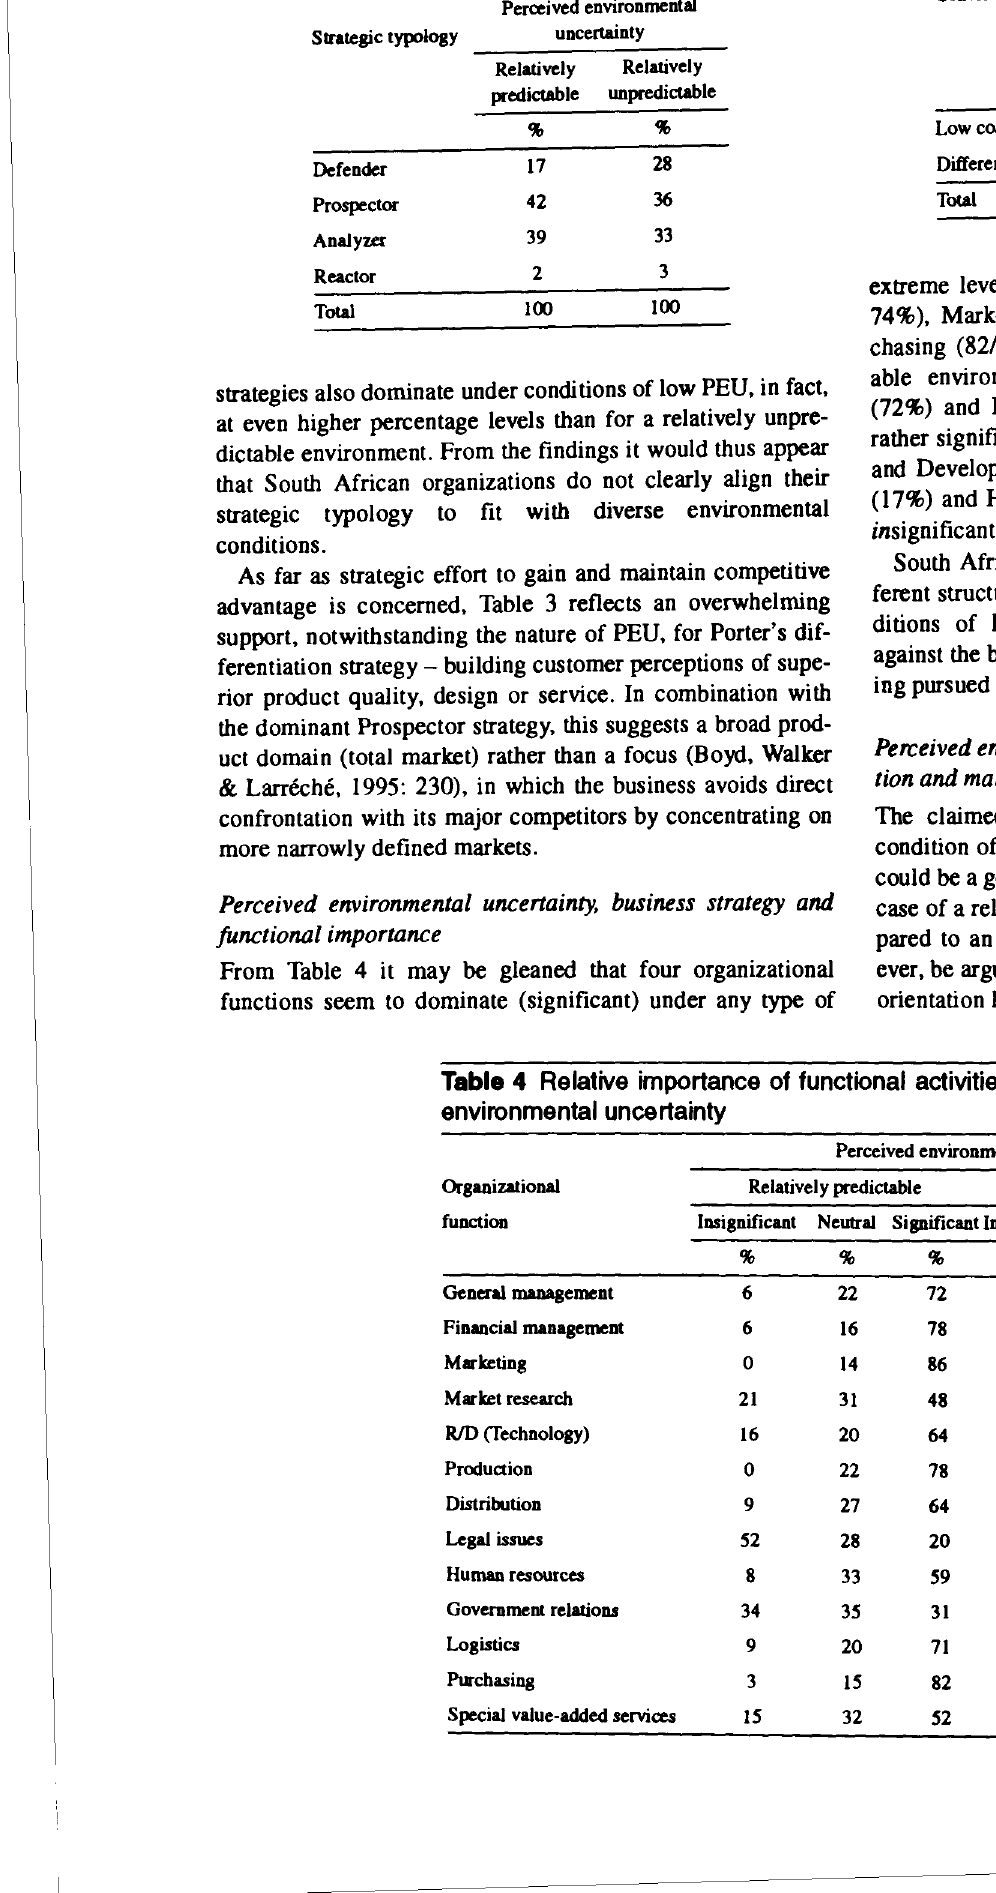
Table 2 Miles & Snow strategic typol